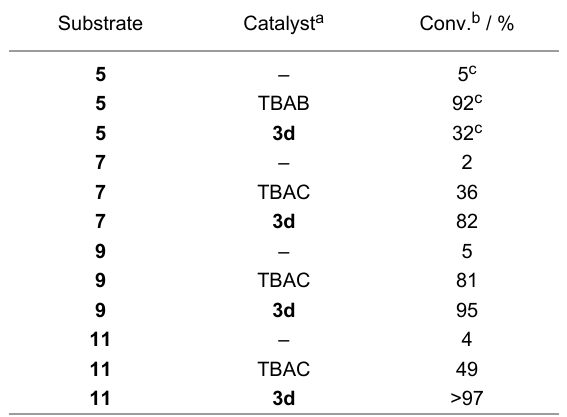
Table 1: Phase-transfer catalyzed alkylation reactions according to Scheme 6.